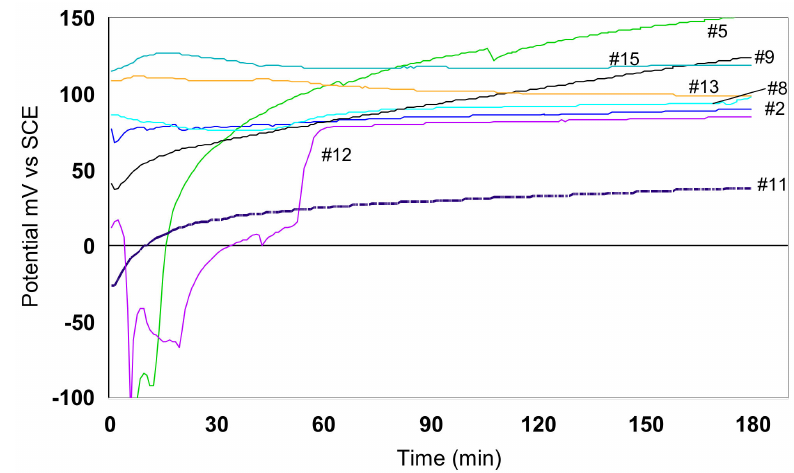
Figure 20. The open circuit potentials measured on the external surfaces of the hypotubes.